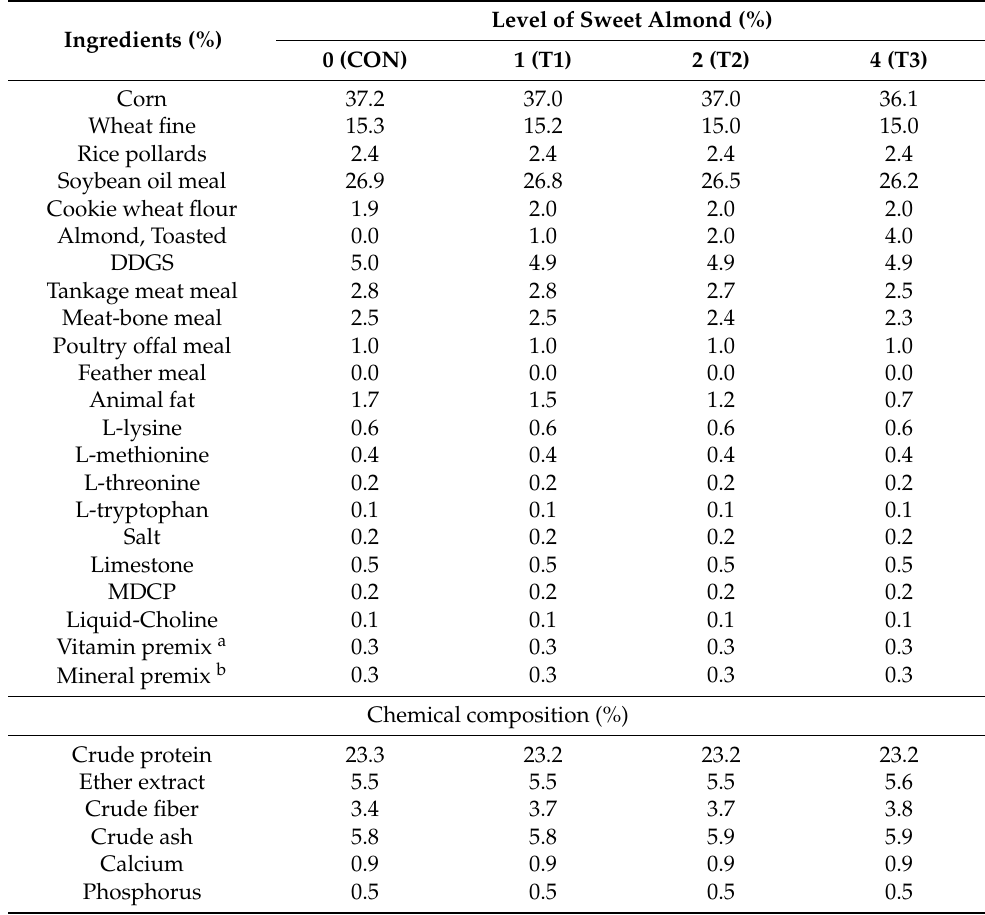
Table 2. Ingredient composition of experimental diets (phase 1/day